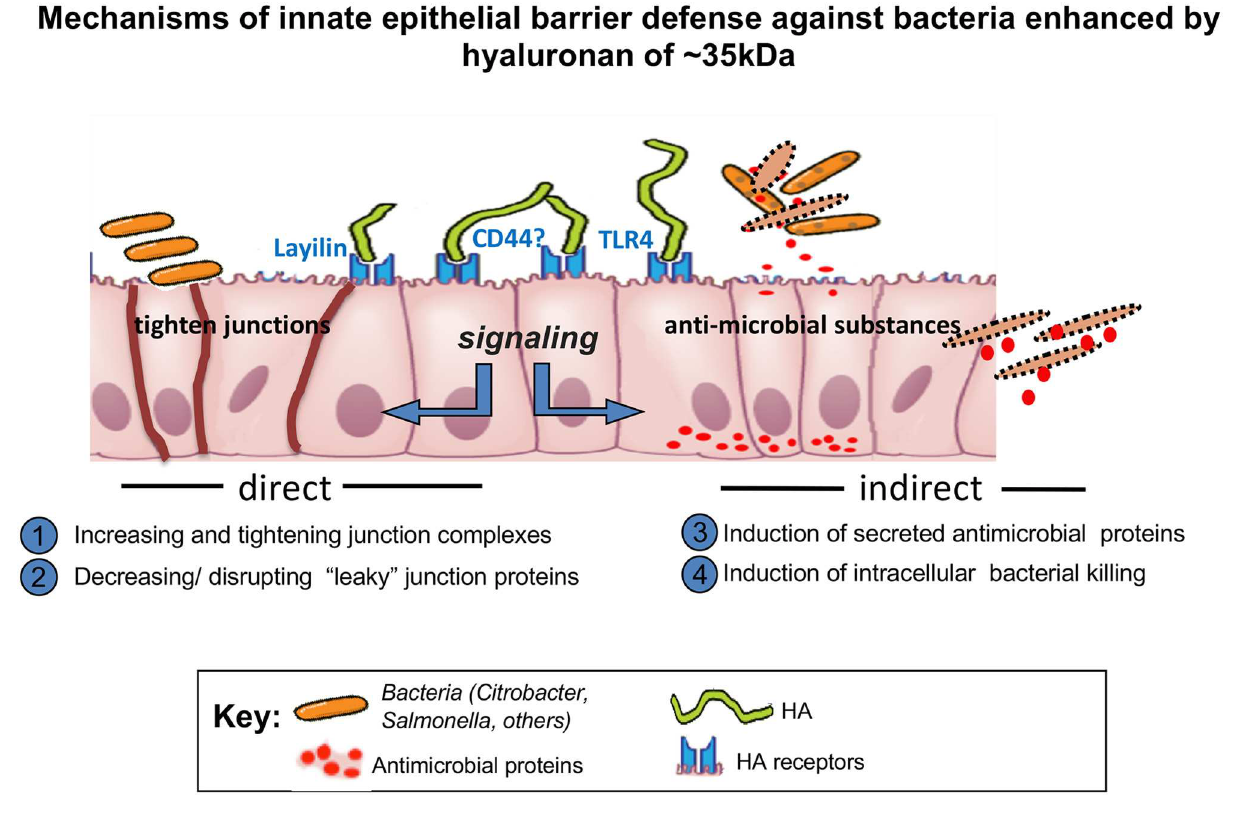
FIGURE 2 | Schematic depicting the activity of HA 35